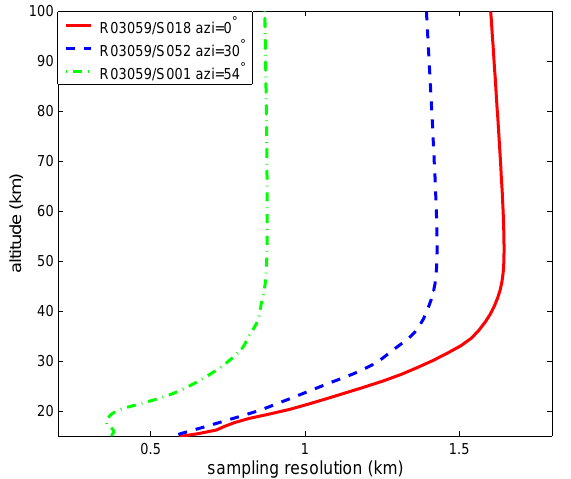
Fig. 2. Averaging kernels of the onion peeling method, at several tangent